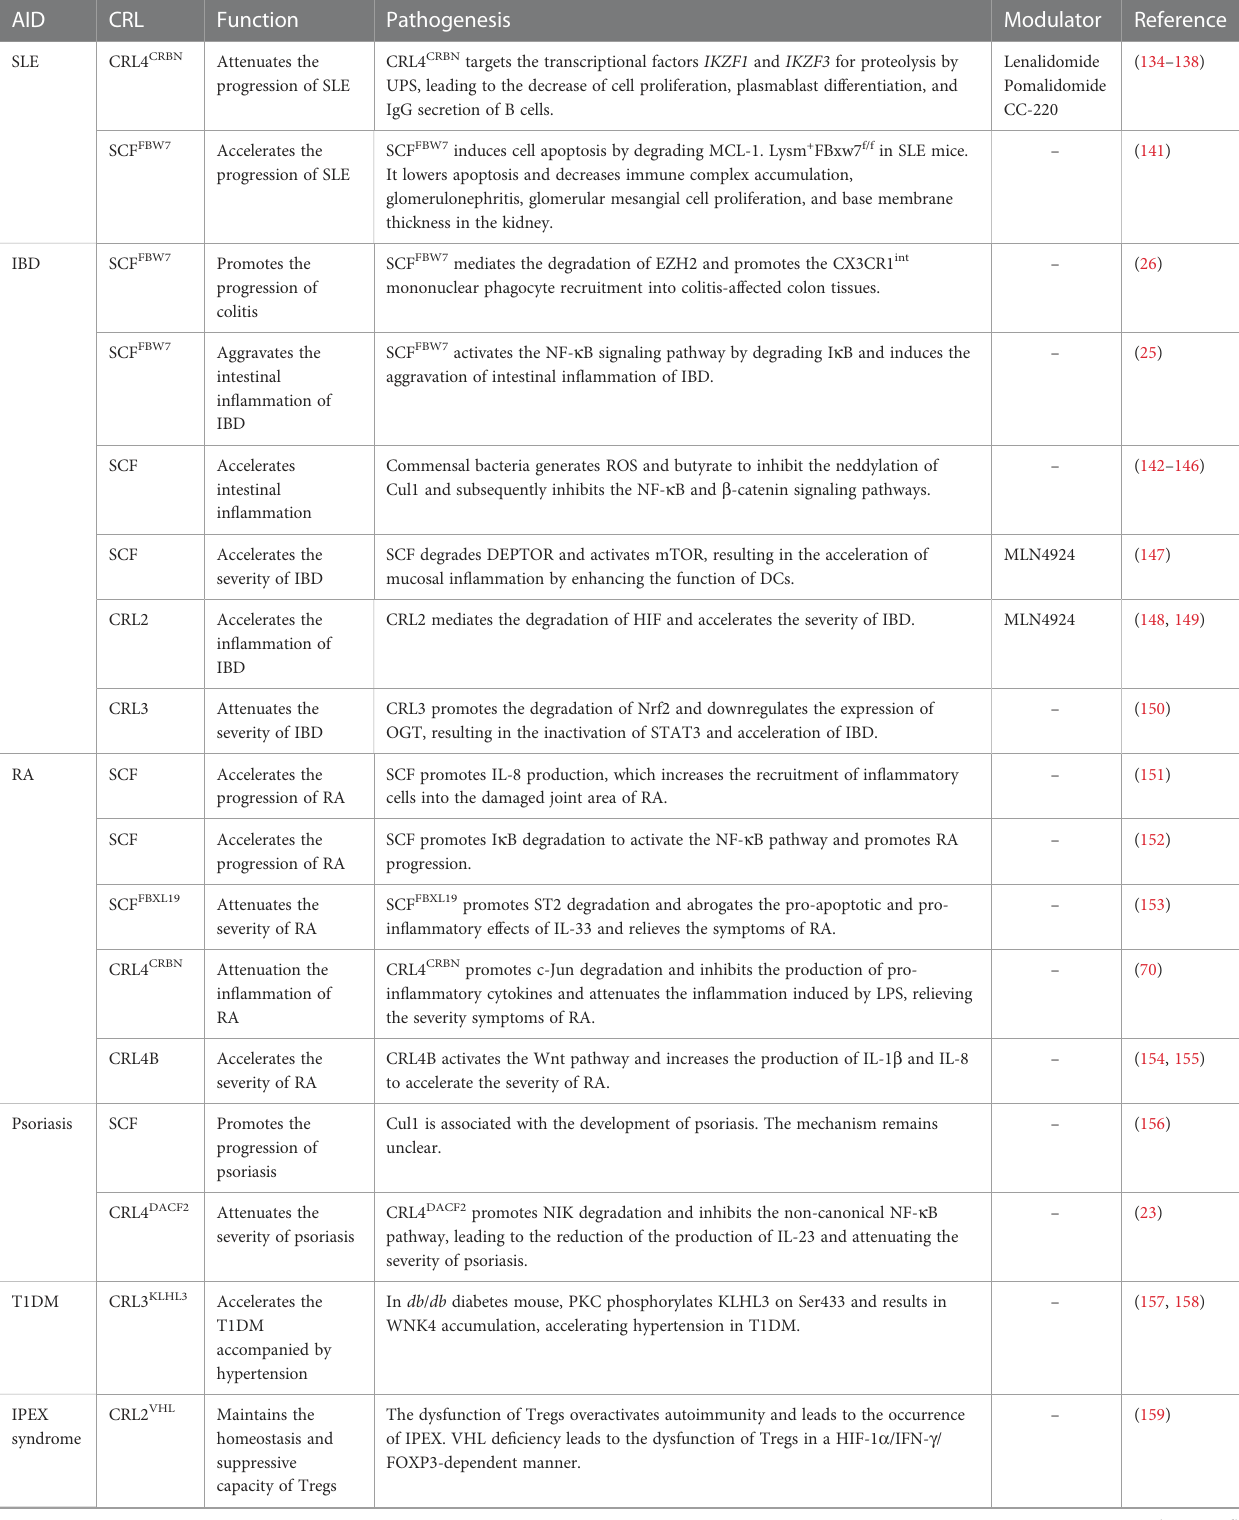
TABLE 1 Multiple functions of Cullin-RING ligases (CRLs) in autoimmune diseases (AIDs).